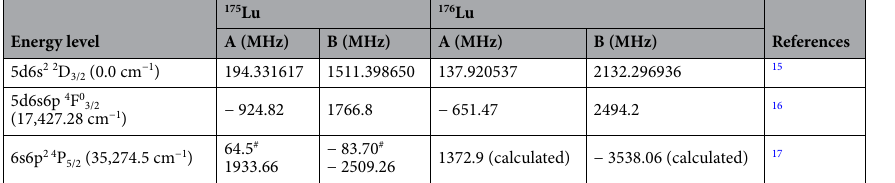
Table 1. HFS coupling constants of lutetium energy levels. # — Value in mK.